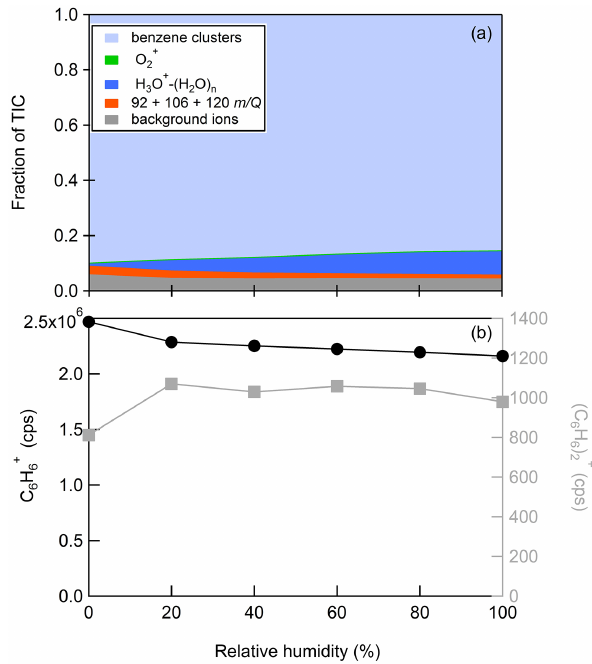
Figure 4. (Top) Dependence of primary ion signal intensities and partitioning between the monomer and dimer on ambient relative humidity ([C 6 H 6 ] = 10ppm) on the CI-ToFMS. (Bottom) Absolute benzene ion signal intensities are shown to be nearly independent of ambient relative